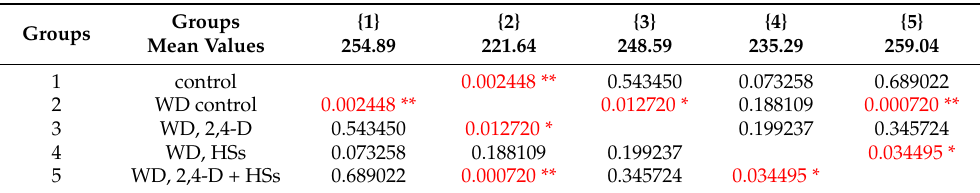
Table 2. ANOVA test for shoot length followed by Duncan test. Values in the cells correspond to p for the difference between the mean values; p ≤ 0.05 is marked with *; p ≤ 0.01—with ** for control plants untreated with either bacteria or HSs and plants grown under water deficit (WD): control, plants treated with Pseudomonas plecoglossicida 2,4-D (2,4-D), humic substances (HSs) and their combinations (2,4-D + HSs).